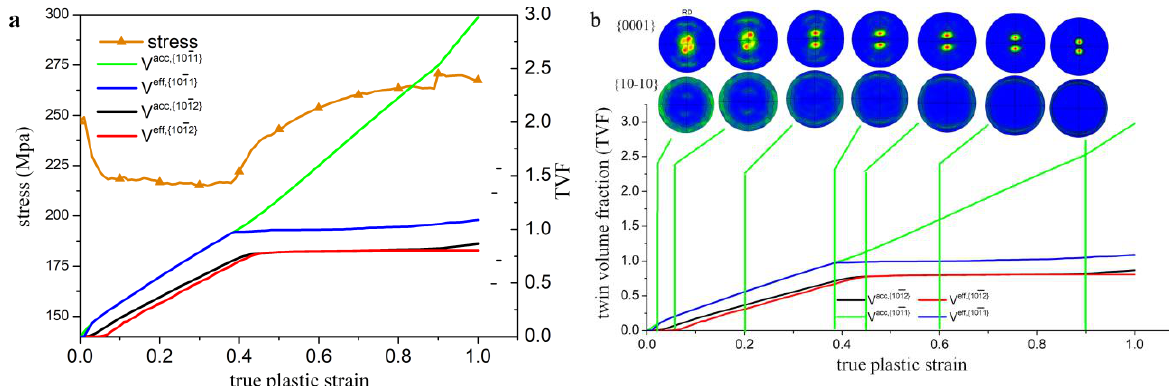
Fig. 8 . simulated ND compression (a) flow stress, {101 ̅ 2} tensile twin and {101 ̅1 } compression twin volume fractions, (b) texture evolution and TVF vs true plastic